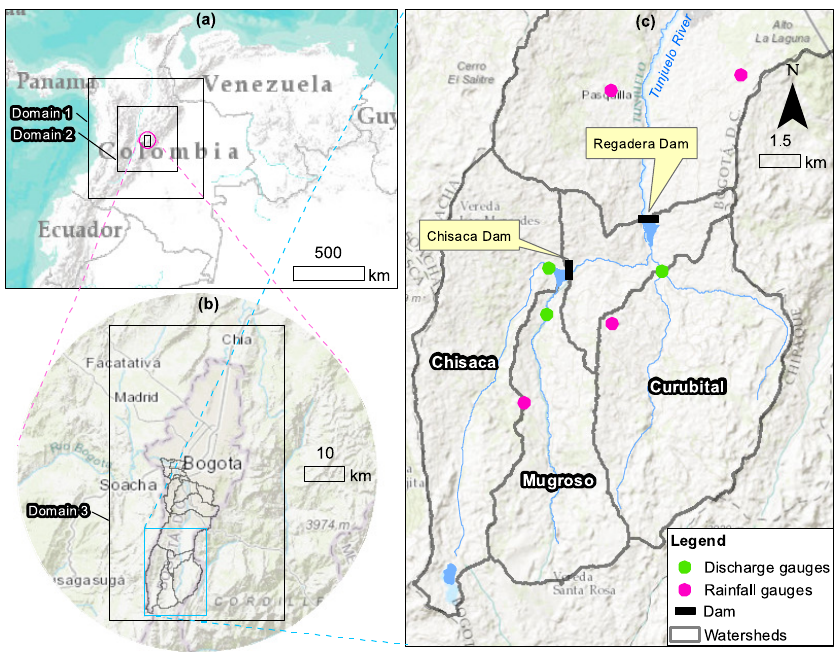
Figure 1. Study area. Service layer credits: Esri, DeLorme, NAVTEQ, TomTom, Intermap, increment P Corp., GEBCO, USGS, FAO, NPS, NRCAN, GeoBase, IGN, Kadaster NL, Ordnance Survey, Esri Japan, METI, Esri China (Hong Kong), swisstopo, and the GIS User